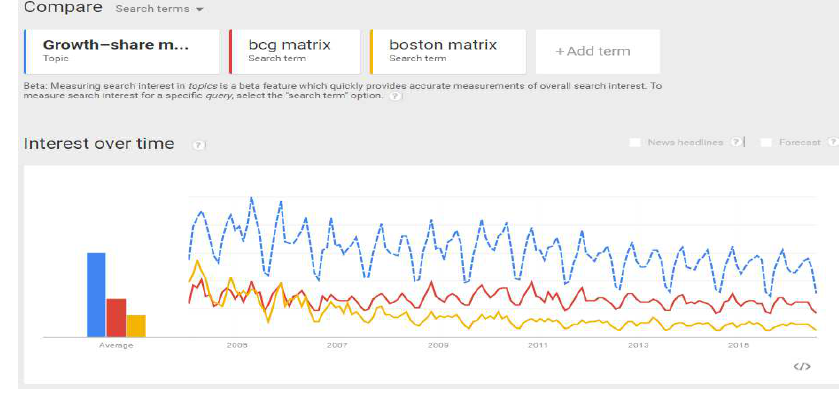
Fig. 1. Search interest for terms related to the BCG